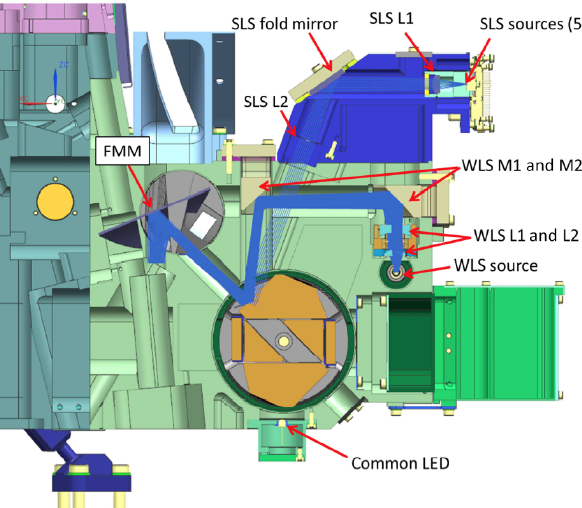
Figure 1. Instrument layout indicating the location of the onboard illumination sources. The light paths of the SLS and WLS are shown using blue lines. The DLED is located within the SWIR module. The location of the CLED is shown. However, as it is not emitting any light at SWIR wavelengths, it is not used for SWIR calibra- tion or monitoring. Figure courtesy of Airbus Defence and Space Netherlands and TNO.